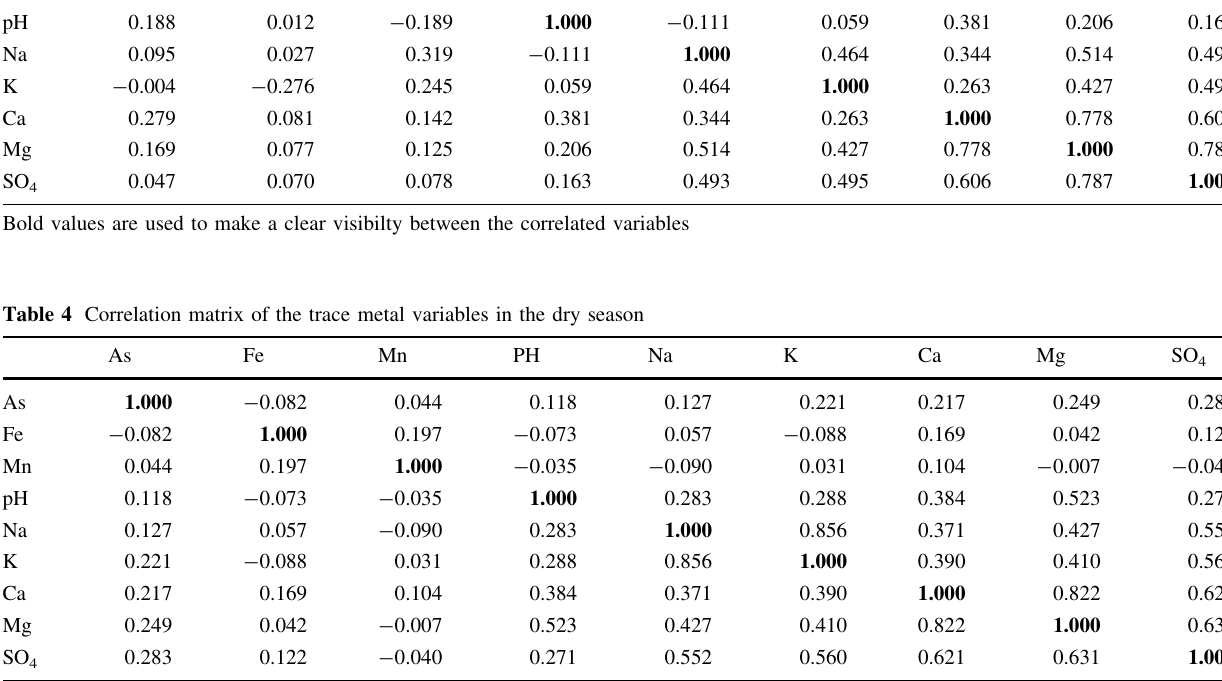
Table 3 Correlation matrix of the trace metal variables in the wet season As Fe Mn PH